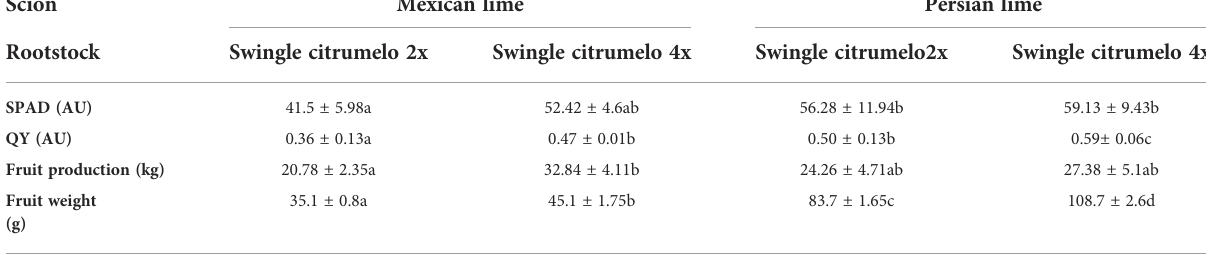
TABLE 1 Leaf physiological characterization of Mexican and Persian limes. Leaf greenness (SPAD unit), effective quantum yield of PSII ( F PSII) within light-adapted leaves, measured in symptomatic leaf from Mexican and Persian limes, grafted onto 2x and 4x Swingle citrumelo rootstocks,